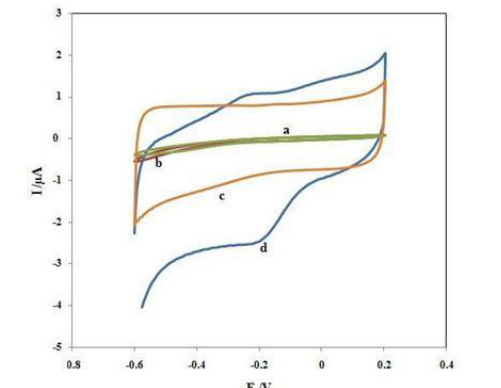
Fig. 2. Cyclic voltammograms of a bare GC electrode (a), nafion- rGO/GC electrode (b) Cyt c on nafion/GC electrode (c), and Cyt Fig. 1. Cyclic voltammograms of a bare GC electrode (a), nafion-rGO/GC electrode (b) Cyt c on nafion/GC electrode (c), and Cyt c on nafion-rGO/GC electrode (d). All the voltammograms are recorded in a PBS buffer pH 7 at a scan rate of 10 mV/s.